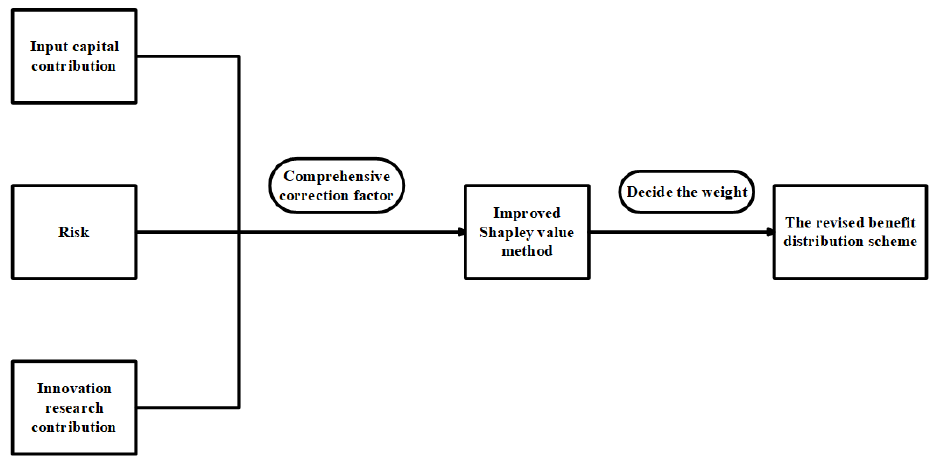
Figure 3. The thought block diagram of the improved Shapley value